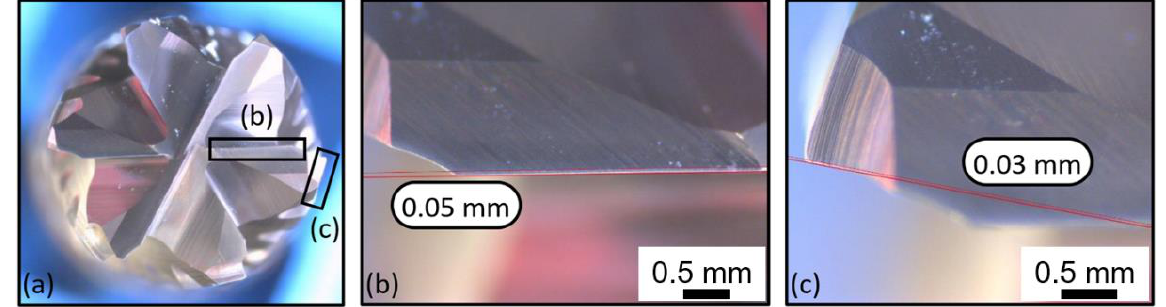
Figure 16. T2: Front view at the worn state: ( a ) global view of the end-mill, ( b ) zoom on a clearance face and ( c ) zoom on the other clearance face.